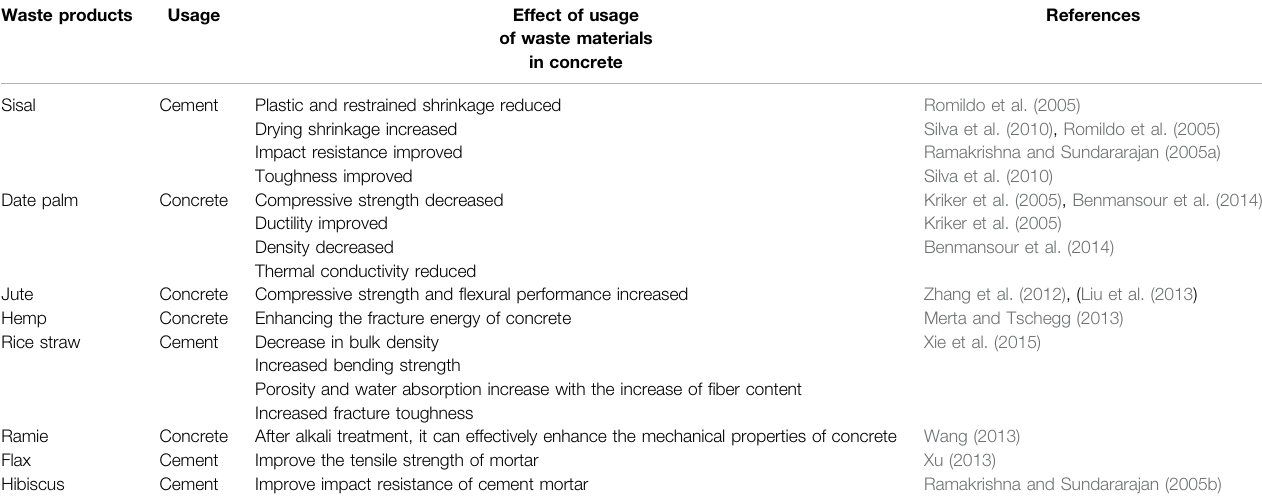
TABLE 2 | Usage of natural plant fi ber in concrete.